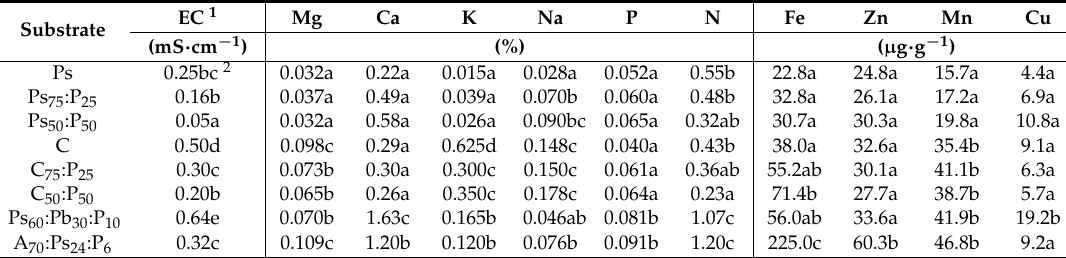
Table 2. Initial chemical characteristics of